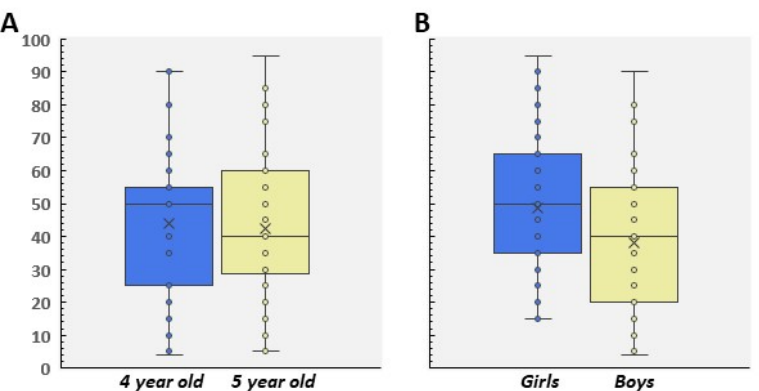
Figure 4. ( A ) Mean percentile of attention scored in 4- and 5-year-old children. ( B ) Mean percentile distributed in girls and boys.